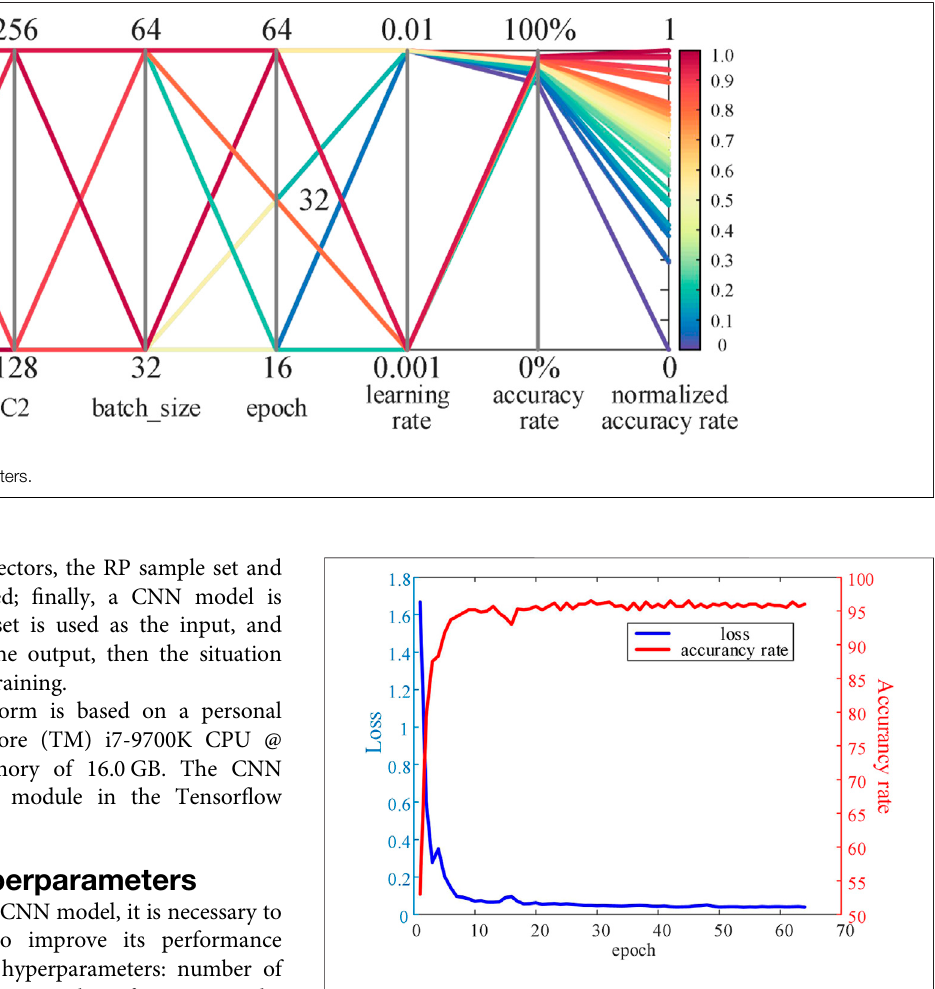
FIGURE 5 | Training accuracy and